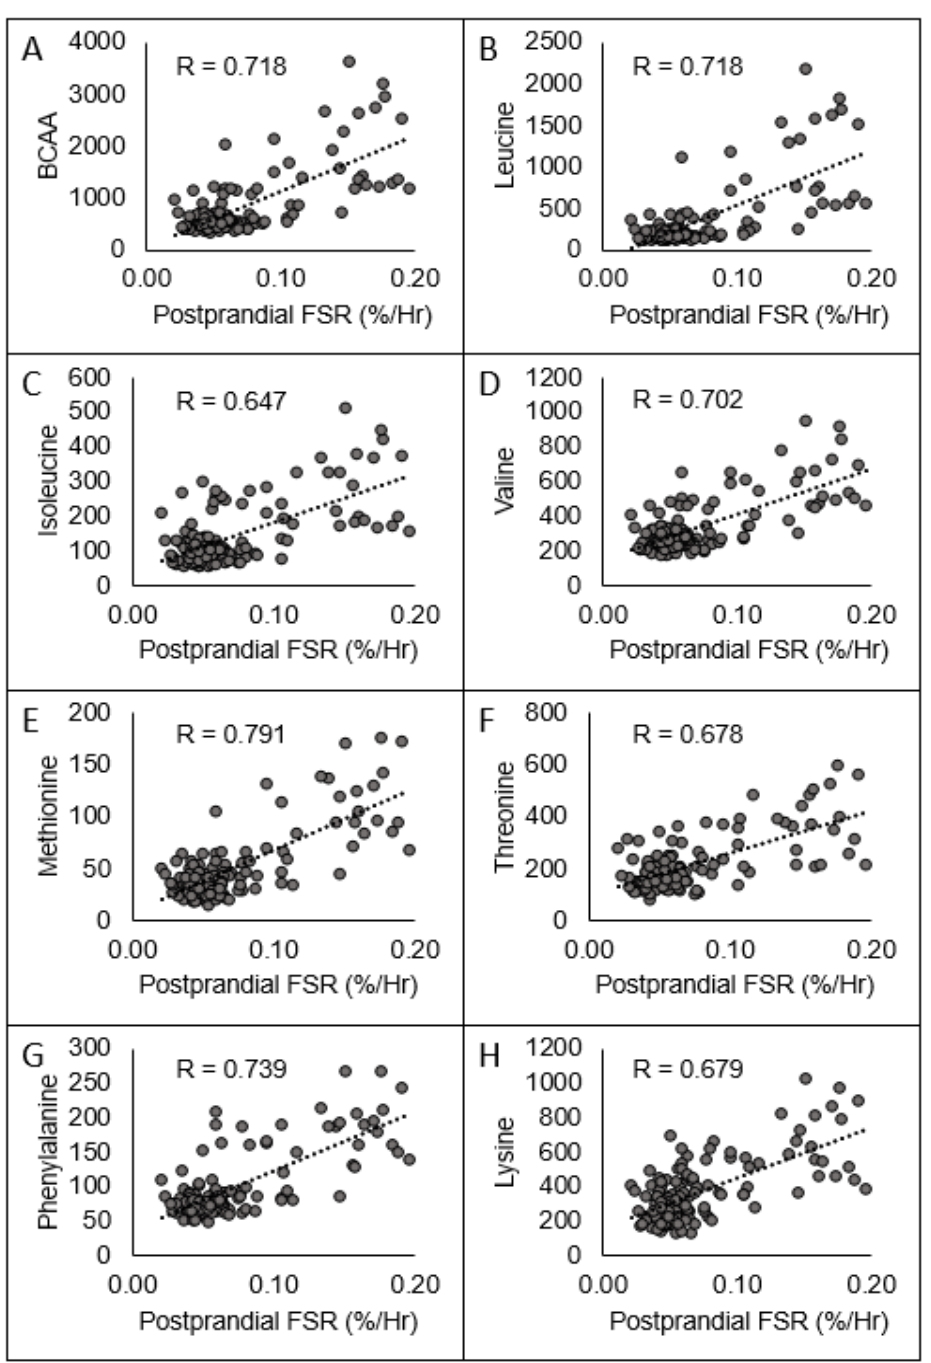
Figure 2. Relationships between C Max (umol / L) of the sum of the branched chain amino acids ( A ; BCAAs) and individual amino acids ( B – H ) to postprandial FSR. Not pictured: non-significant relationships between tryptophan and histidine.